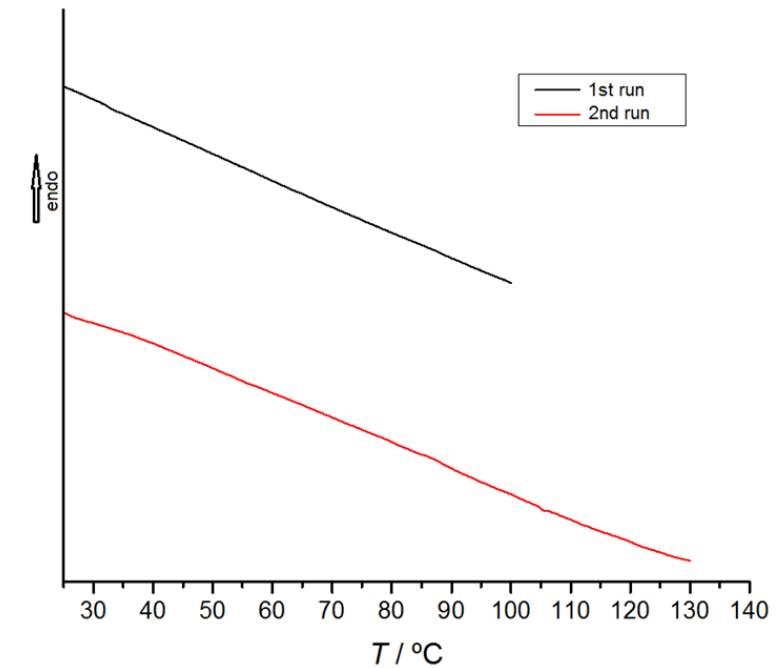
Figure 2. DSC curve of LAlaRe between 15ºC and 120ºC showing no transformations involving enthalpy changes. Table 1. Crystal and structure refinement data for LAlaRe. Table 2. Selected bond lengths (pm) and